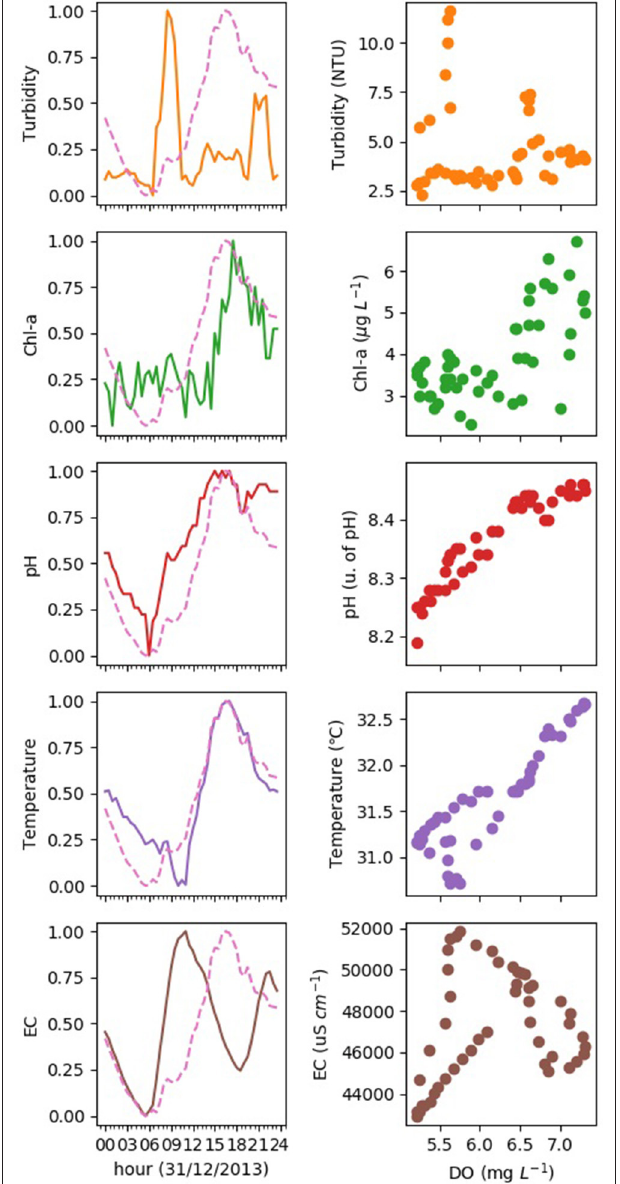
FIGURE 3 | Daily changes of 5 physochemical parameters and the correlations with DO. Solid and dotted lines in left column represent water quality parameters and DO, respectively. Relationships between water quality parameters and DO are illustrated in the right scatterplots. All the water quality parameters have been scaled by using the min-max normalization in Equation 1.